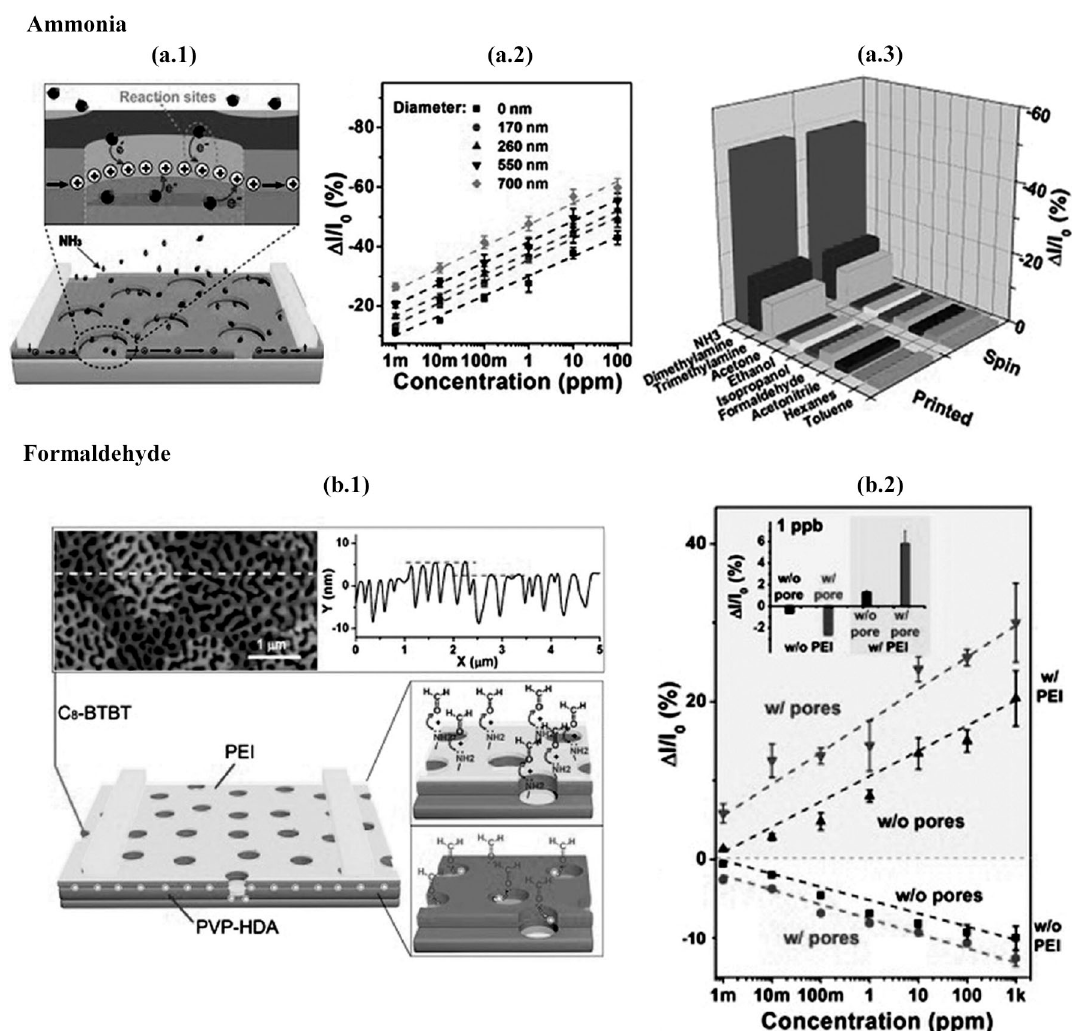
Figure 9. High-sensitivity gas sensors for ammonia and formaldehyde detection: ( a.1 ) Schematic diagram of a porous DPP2T-TT TFT-based NH 3 sensor. The magnified cartoon illustrates the charge transport reaction occurring at the conductive channel with NH 3 . ( a.2 ) Current response to NH 3 with concentrations ranging from 1 ppb to 100 ppm and pore sizes from 0 to 700 nm. ( a.3 ) Sensor performance of transistors using printing and spin coating. All VOCs at 1 ppm. ( b.1 ) Schematic diagram of a porous C8-BTBT TFT-based formaldehyde sensor. The atomic force microscopy figure and cross-sectional profile of the semiconductor film are shown. Formaldehyde interaction with the TFT is illustrated. ( b.2 ) Current response of transistor with (inverted triangle) and without (triangle) pores with a PEI film as compared to pristine transistors with (circle) and without (square) pores to formaldehyde with concentrations ranging from 1 ppb to 1000 ppm. The inset shows the magnified current responses at 1 ppb. The pore size was ca. 500 nm. Reprinted from [85], with permission, from John Wiley and Sons, ©